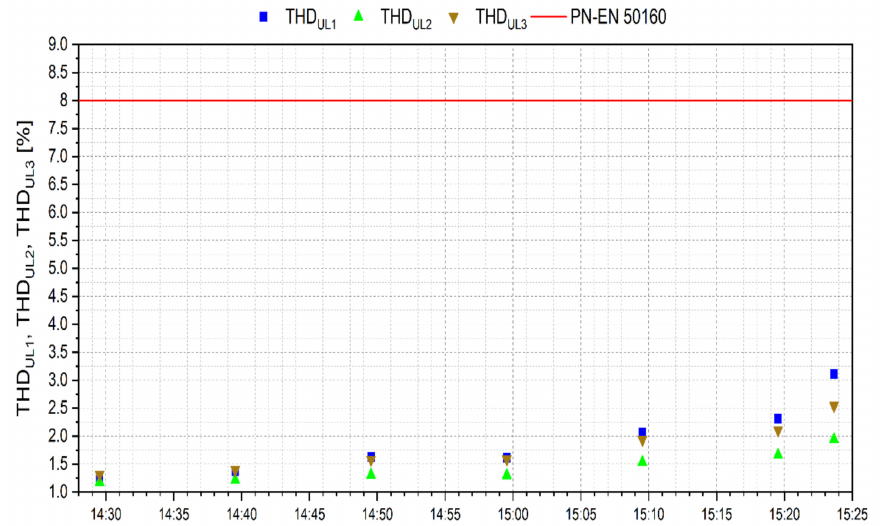
Figure 9. Total harmonic distortion of voltage variation during one charging